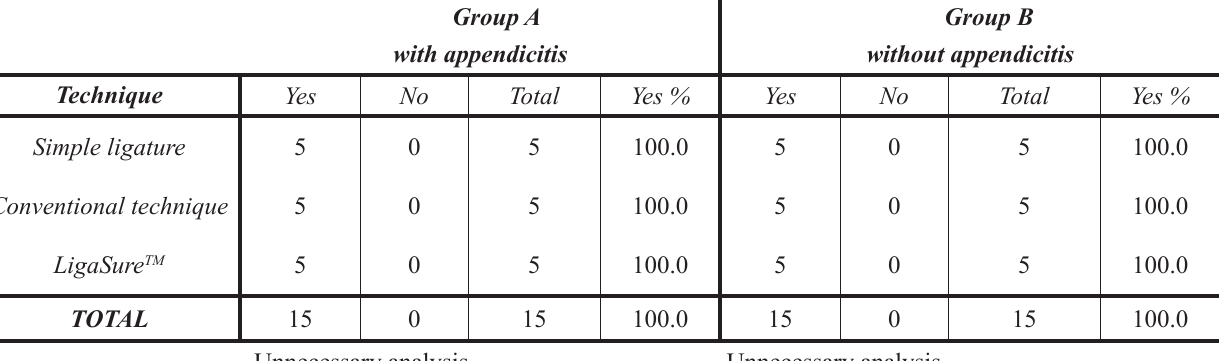
TABLE 5 - Rabbits from groups A and B in the three operative techniques for chronic inflammatory process (Figure 2).